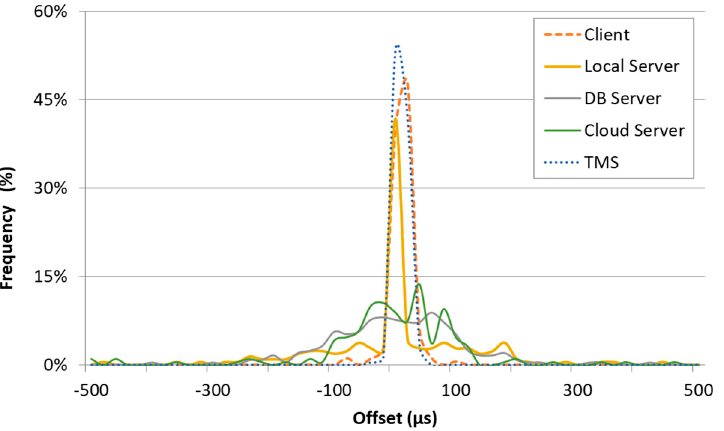
Figure 8. Probability Density Function (PDF) estimate of the residual offset after NTP daemon corrected the local system clock of the devices involved in the experiments.